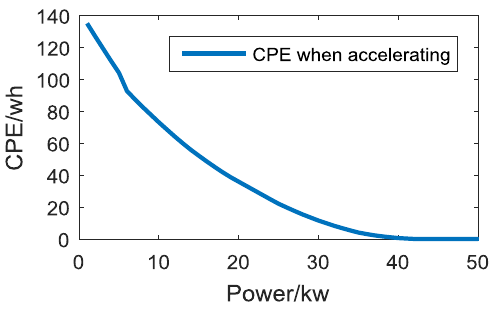
Figure 11. CPE results when accelerating.